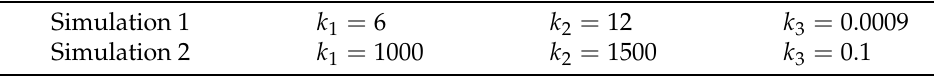
Table 2. Gains for a classical PID